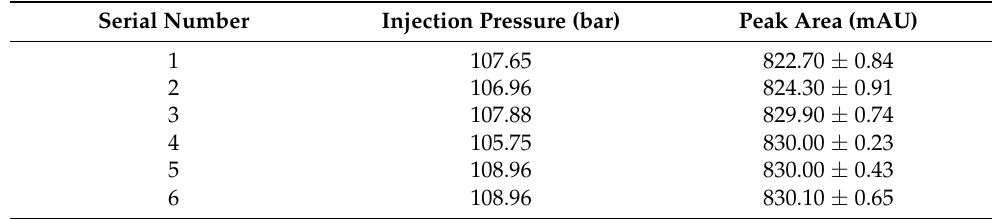
Table 2. Precision parallel measurement.